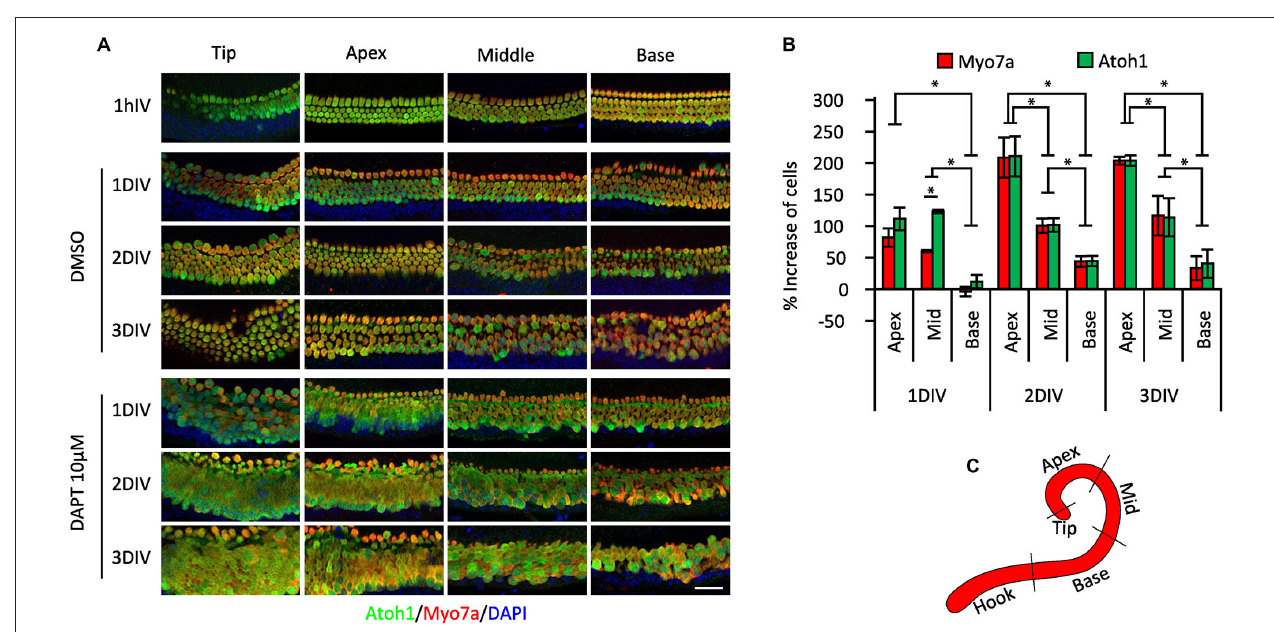
Myosin VIIa-labeled cells and GFP-labeled cells in the different regions of the cochlea after DAPT 10 µ M treatment compared to vehicle (same as shown in A ). N = 4. * p = 0.030 (Mann-Whitney pairwise comparisons). Error bars: SEM. (C) Schematic view of the cochlear portions evaluated in (A,B)